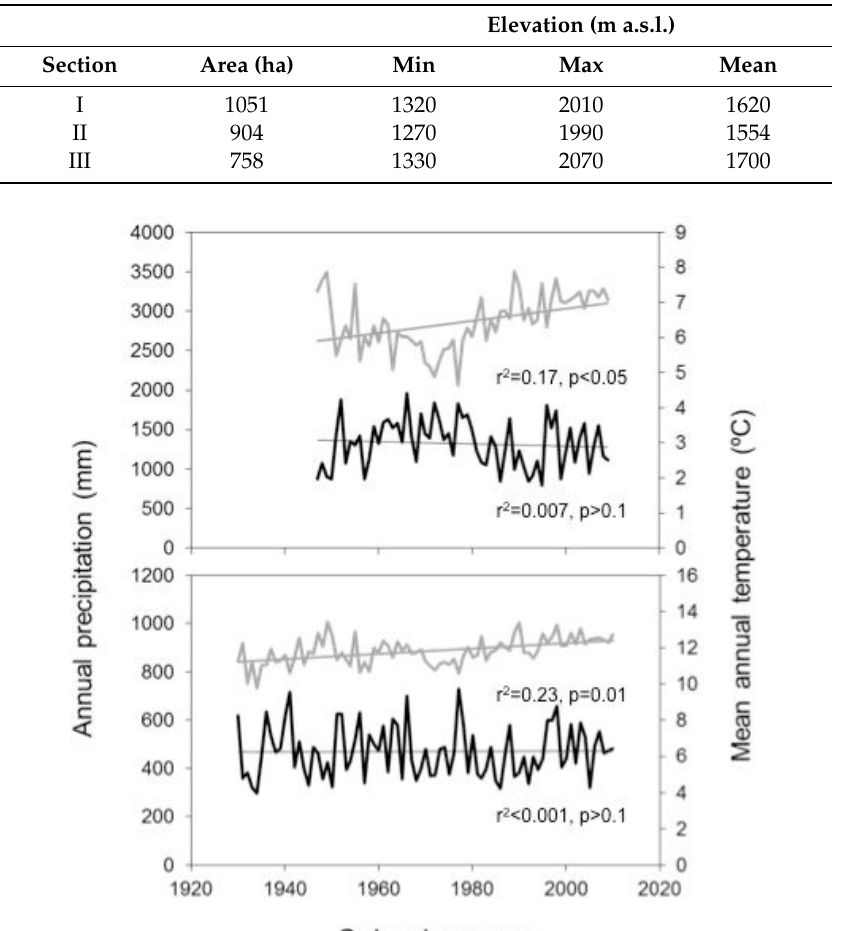
Table A1. Altitude of the sections located in Navafr í a.